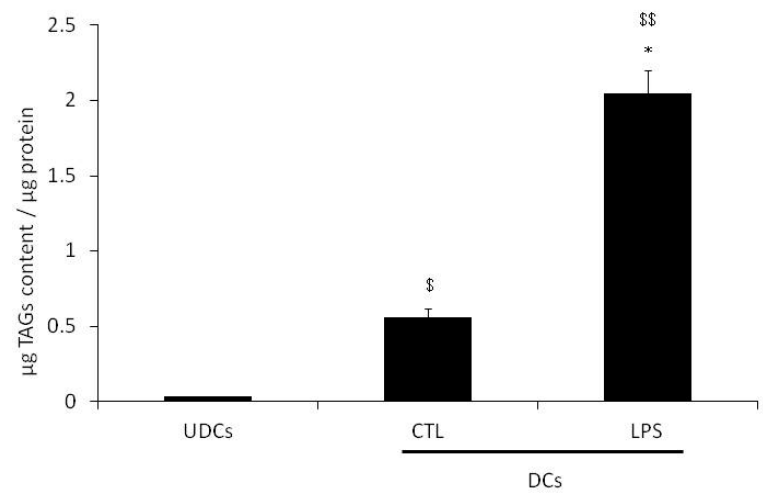
Figure 2. Triacylglycerols (TAGs) content in undifferentiated 3T3-L1 cells (UDCs) and in 3T3-L1 cells differentiated into adipocytes (DCs), untreated (CTL) or treated with lipopolysaccharide (LPS). DCs were treated for 4 h in media supplemented with water (CTL) or 1 μ g LPS/mL (LPS). TAGs content